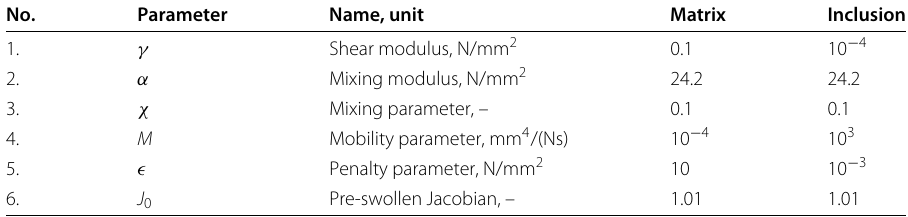
Table 1 Material parameters of the two-phase periodic hydrogel composites